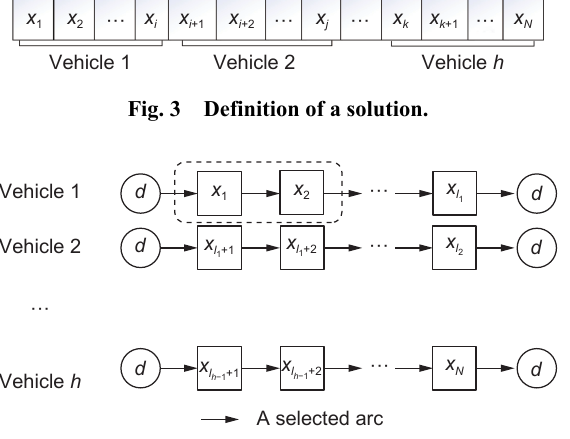
Fig. 3 Definition of a solution.